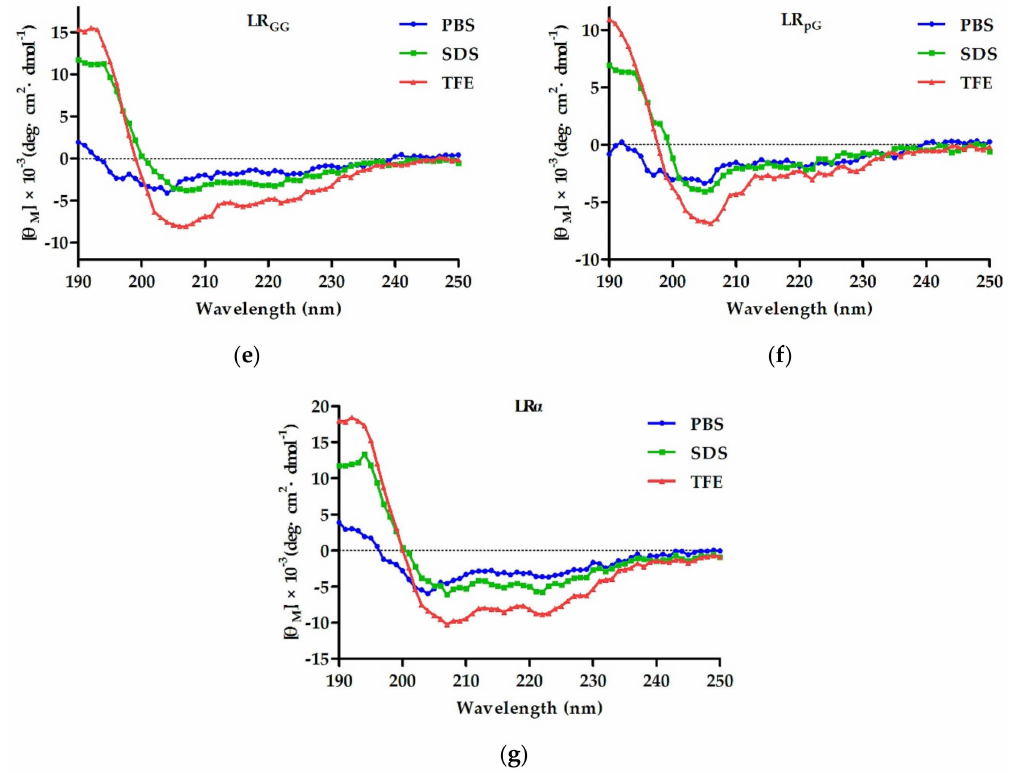
Figure 1. The circular dichroism (CD) spectra of ( a ) IR GG , ( b ) IR pG , ( c ) FR GG , ( d ) FR pG , ( e ) LR GG , ( f ) LR pG , and ( g ) LR α were dissolved in 10 mM phosphate-bu ff ered saline (PBS) ( blue ), 30 mM sodium dodecyl sulfate (SDS) ( green ), and 50% trifluoroethanol (TFE) ( red ). The average value after three scans of every sample is shown. The CD spectrum of the bu ff er was subtracted. Table 2. Minimum inhibitory concentrations (MICs) ( µ M) and therapeutic index (TI) of the designed peptides. Bacterial